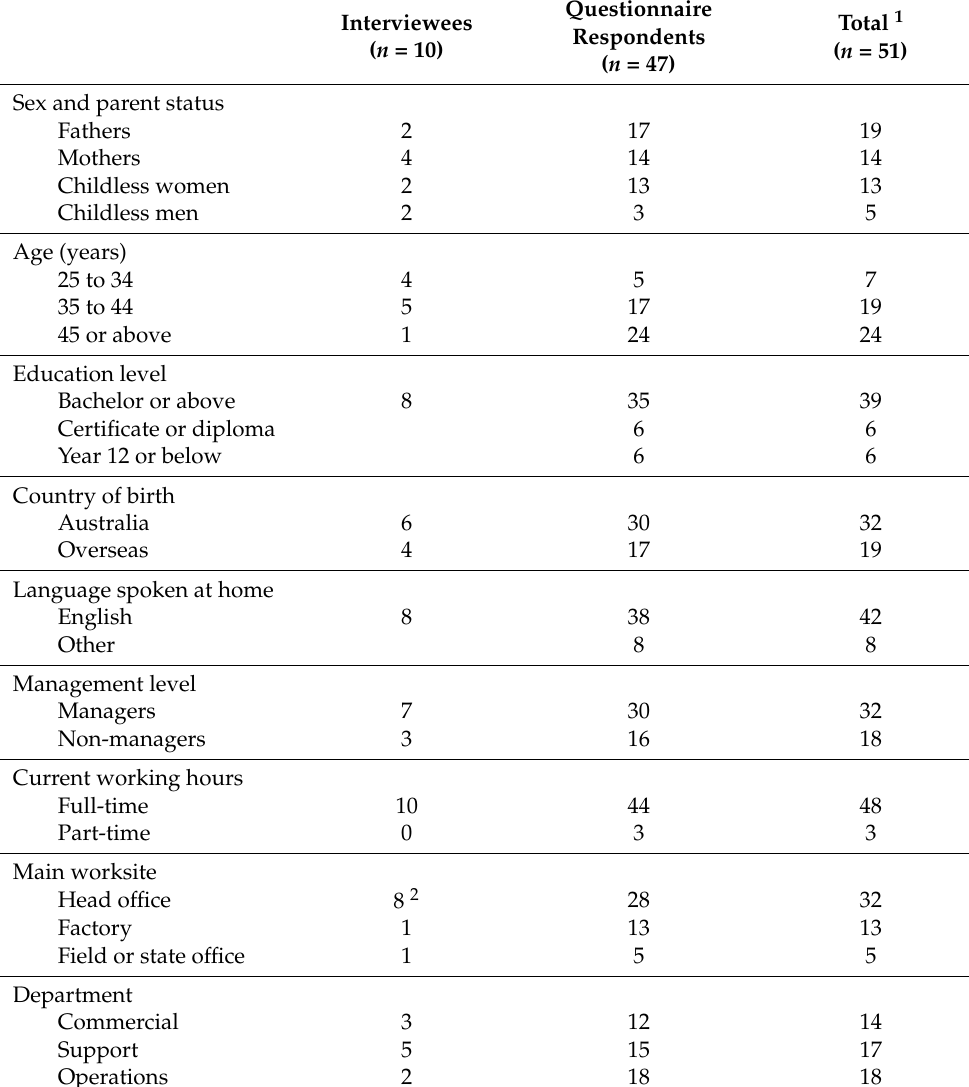
Table 1. Participant demographic characteristics (excluding missing